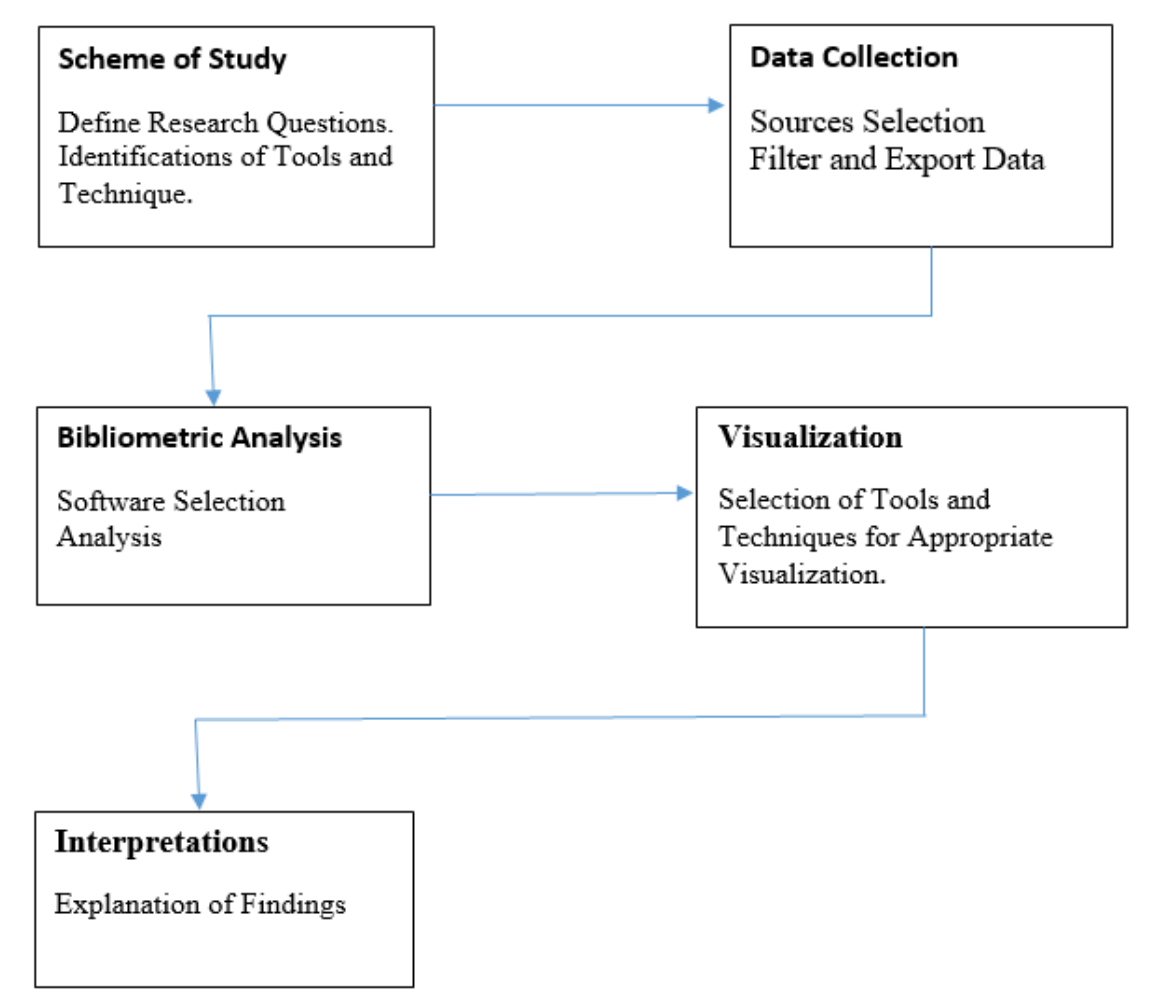
Figure 1. Process of Bibliometric Analysis.